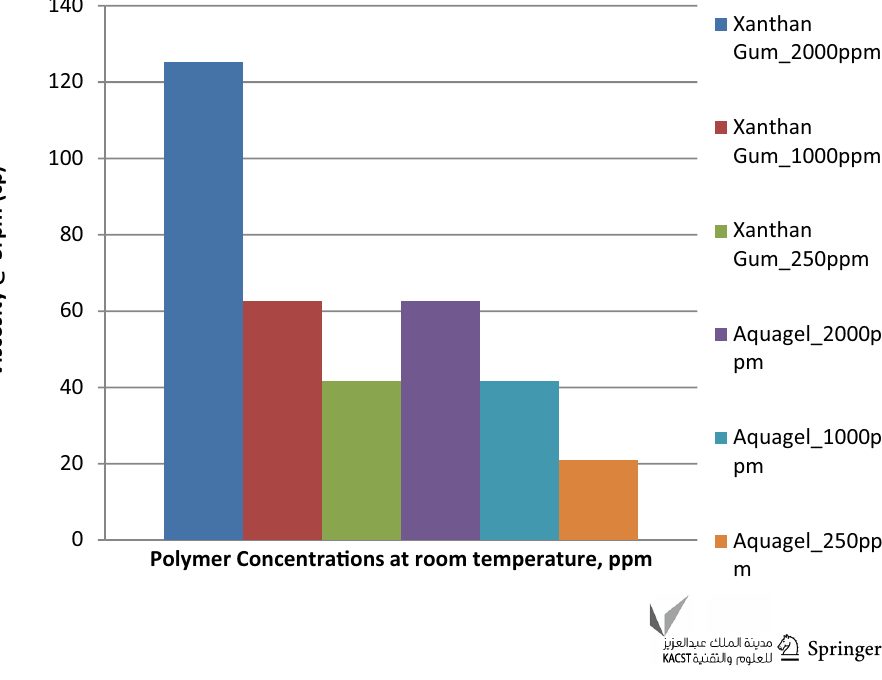
Fig. 9 Viscosity (cp) of xanthan gum and aquagel solutions at various concentration levels at a shear rate of 3